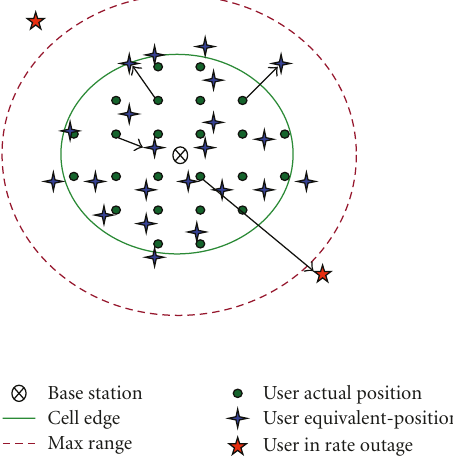
Figure 2: Initial uniform and shadowed user